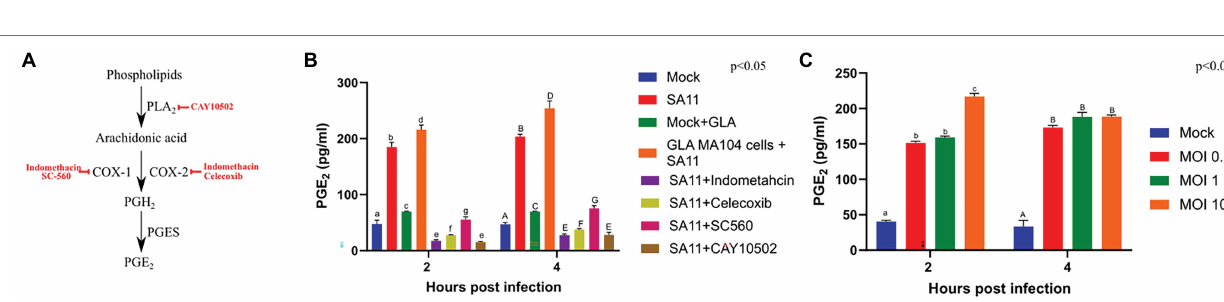
FIGURE 2 | Rotavirus increases the concentration of prostaglandin E 2 in MA104 cells in a dose- and time-dependent manner. (A) CAY10502 inhibits the releases of AA from phospholipids, while indomethacin non-specifically inhibits both COX-1 and COX-2. In contrast, SC-560 specifically inhibits COX-1 and celecoxib specifically inhibits COX-2. (B) The amount of PGE 2 produced during rotavirus (SA11) infection (MOI = 5) as determined by ELISA was compared to uninfected MA104 cells (mock), in the presence and absence of GLA and inhibitors of the PGE 2 -biosynthetic pathway at 2 and 4 h post-infection. (C) The amount of PGE 2 produced at increasing multiplicities of infection (MOI) at 2 and 4 h post-infection. Error bars indicate the standard error of the mean ( n = 3). Lowercase and uppercase letters indicate a significant difference ( p < 0.05) compared to the control. Cyclooxygenases (COX1/2), phospholipaseA 2 (PLA 2 ), prostaglandin E 2 synthase (PGES); and prostaglandin E 2 (PGE 2